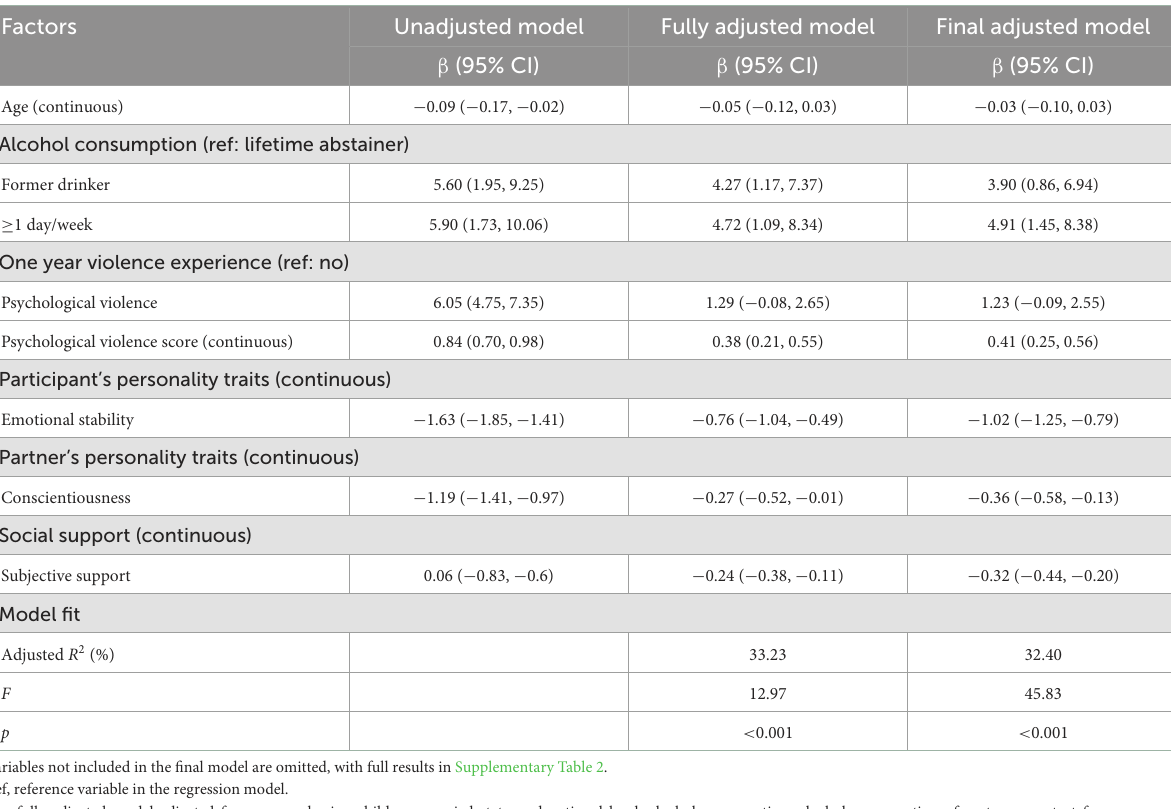
TABLE 4 Linear regression on selected associated factors for psychological distress among nurses.